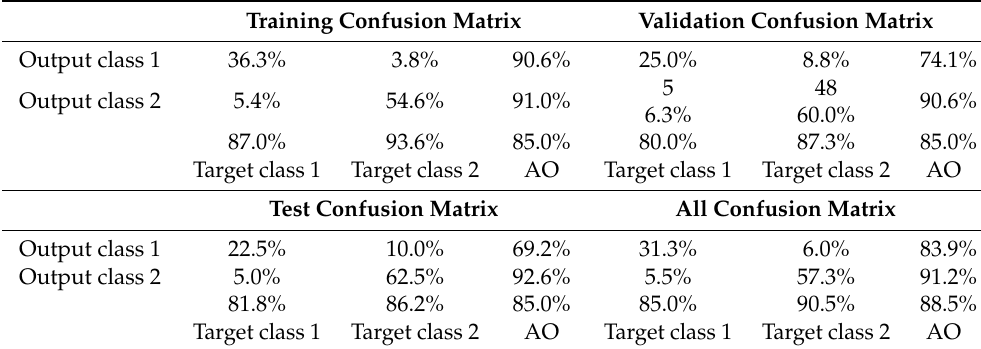
Table 3. Confusion matrix results from the application of the NN classification on RapidEye VI.